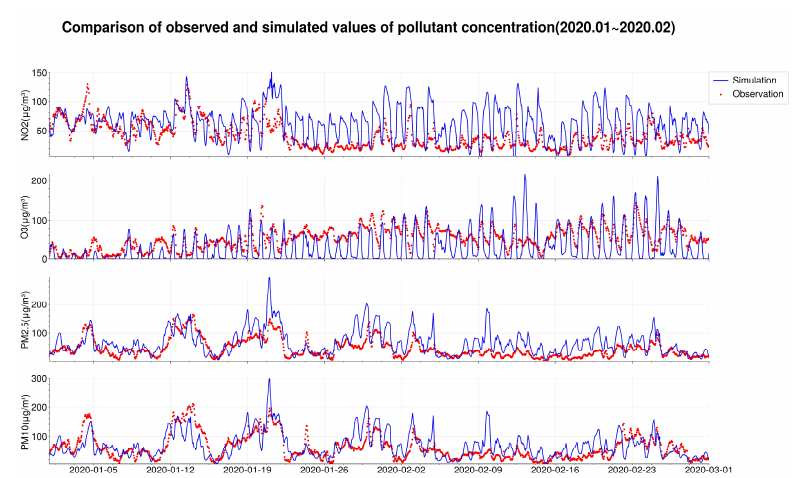
Figure 3. Hour-by-hour near-surface NO 2 , O 3 , PM 2.5 , and PM 10 ( µ g/m 3 ) concentrations in Nanjing from 1 January to 29 February 2020 for observed (red dots) and simulated (blue line) values.